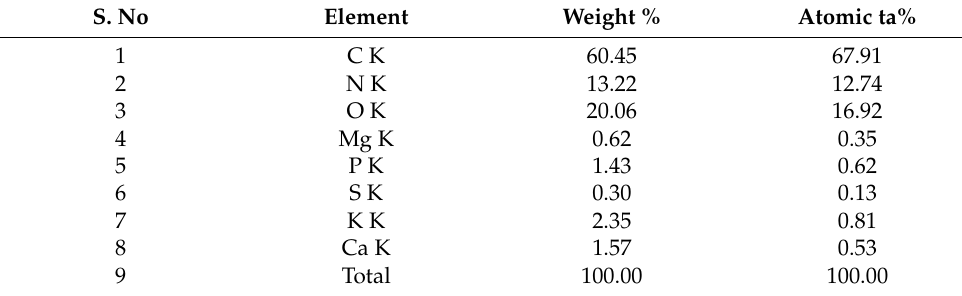
Figure 9. EDX analysis of CPC. Table 2. Elemental conformation of CPC heterogeneous catalyst.